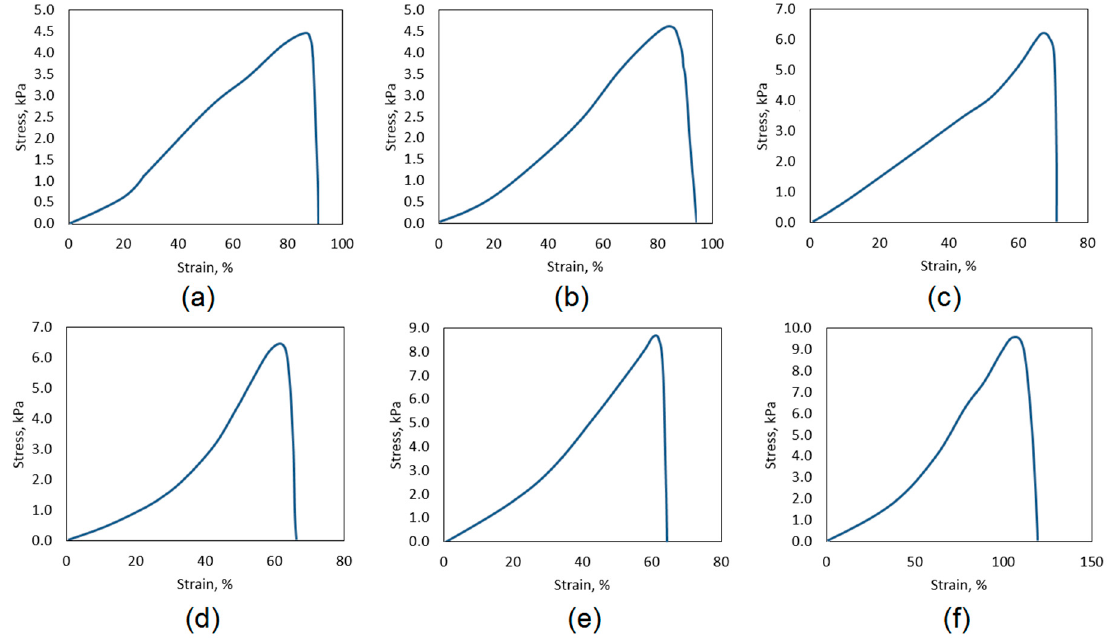
Figure 10. Tensile strength of the hydrogels containing: ZnO ( a ) CS-ZnO-1; ( b ) CS-ZnO-2; ( c ) CS-ZnO-3; ( d ) CS-ZnO-4; ( e ) CS-ZnO-5; and ( f ) CS-ZnO-6 .